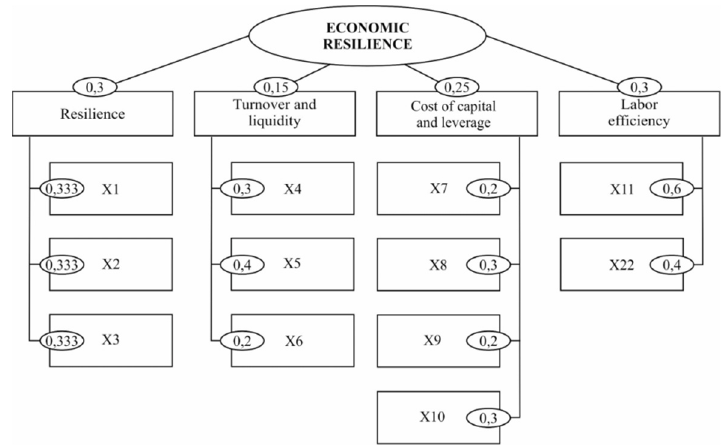
Figure 5. Two-level hierarchy of factors for assessing resilience.